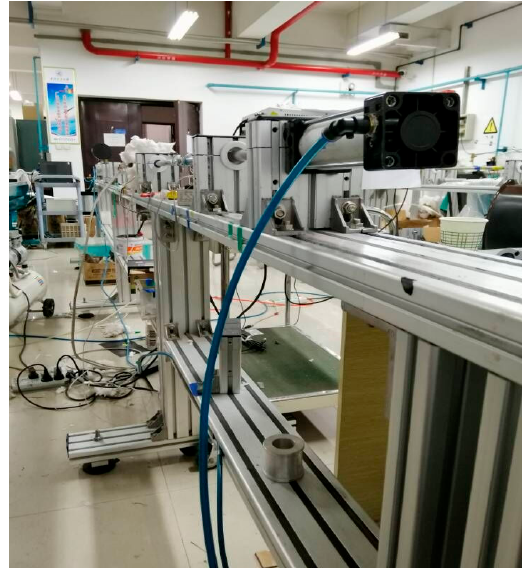
Figure 5. Hopkinson pressure bar experimental device.